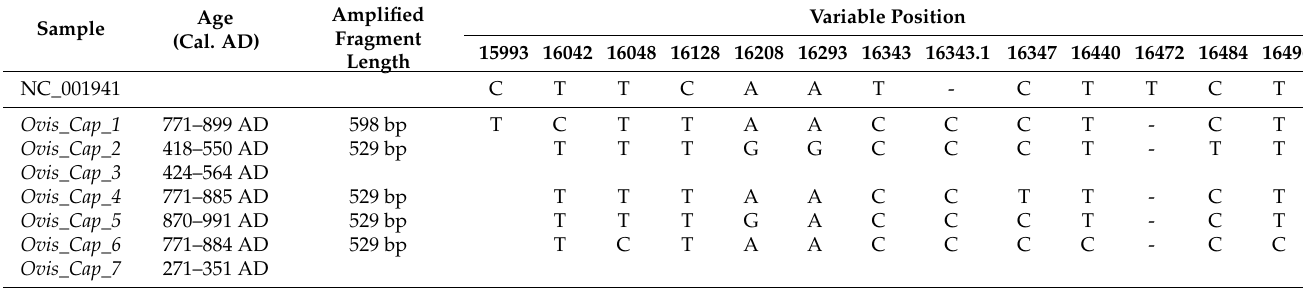
Table 1. Radiocarbon dating, informative DNA sequence length, and SNP positions for the Capidava cohort. Blank areas denote a lack of information.